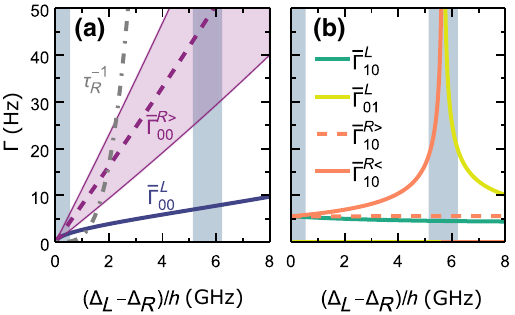
FIG. 4. The quasiparticle-number-conserving rates for a single-junction transmon versus the gap asymmetry. (a) The quasiparticle rates for transitions that do not change the qubit logical state. The dot-dashed curve for the relaxation rate grows rapidly as ((cid:2) L − (cid:2) R ) 7 / 2 (see Appendix B 3). (b) The quasipar- ticle rates for transition changing the logical state of the qubit.